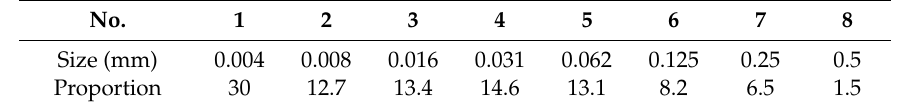
Figure 1. Layout of the field study reach section and its computational mesh. ( a ) layout of the study river section; ( b ) computational mesh. Table 1. The fraction of suspended load being simulated.